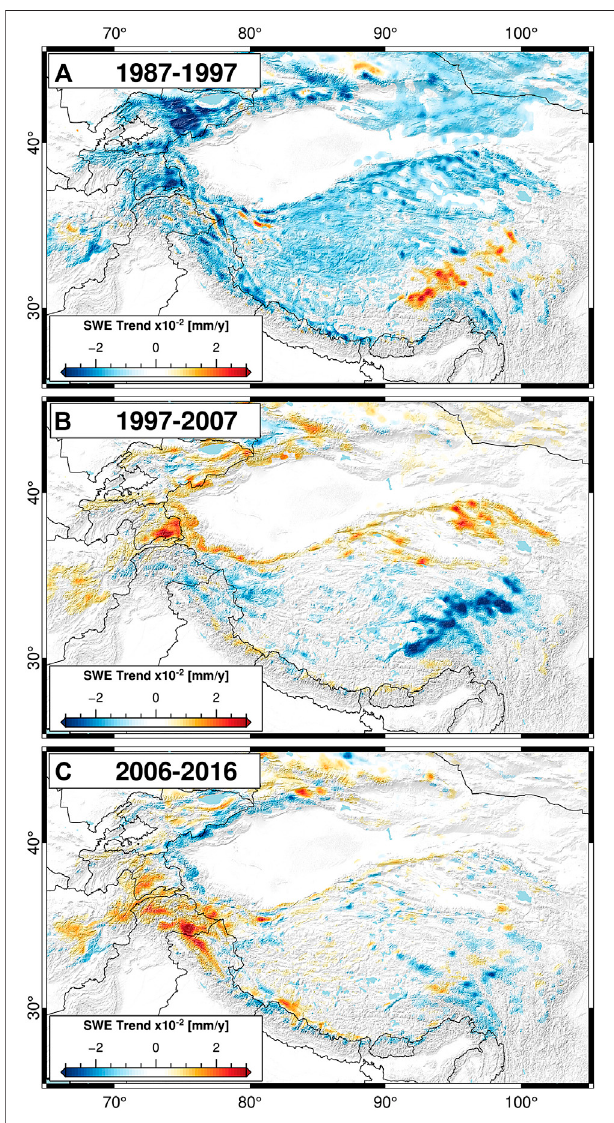
FIGURE 7 | Annual snow-water equivalent (SWE) trends from (A) 1987 – 1997, (B) 1997 – 2007, and (C) 2006 – 2016. There are stark differences in the spatial distribution of SWE trends depending on the decade chosen. In particular, the trends in the early part of the time series (1987 – 1997) are signi fi cantly more negative than SWE trends over the past two decades. Note that themagnitude scaling ofthe decadal trendsisthree times aslargeasthat of the long-term annual trends (1987 – 2016, see Figure 3 ).